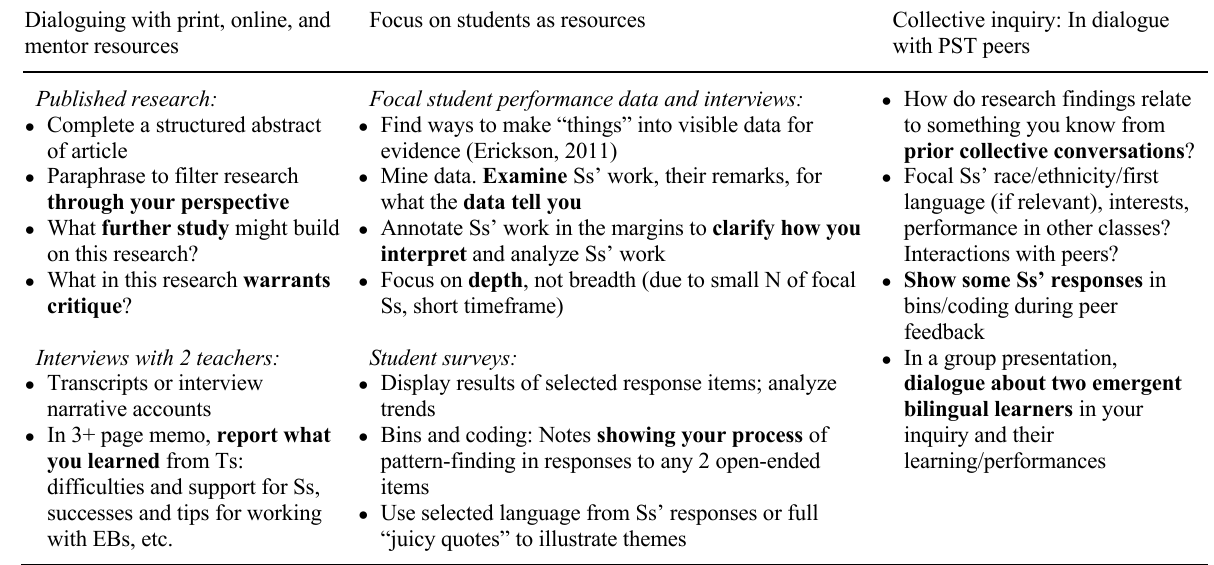
Table 1: Engaging in a Democracy of Resources: Guided Dialogic Teacher Inquiry in Coursework Activity a Dialoguing with print, online,